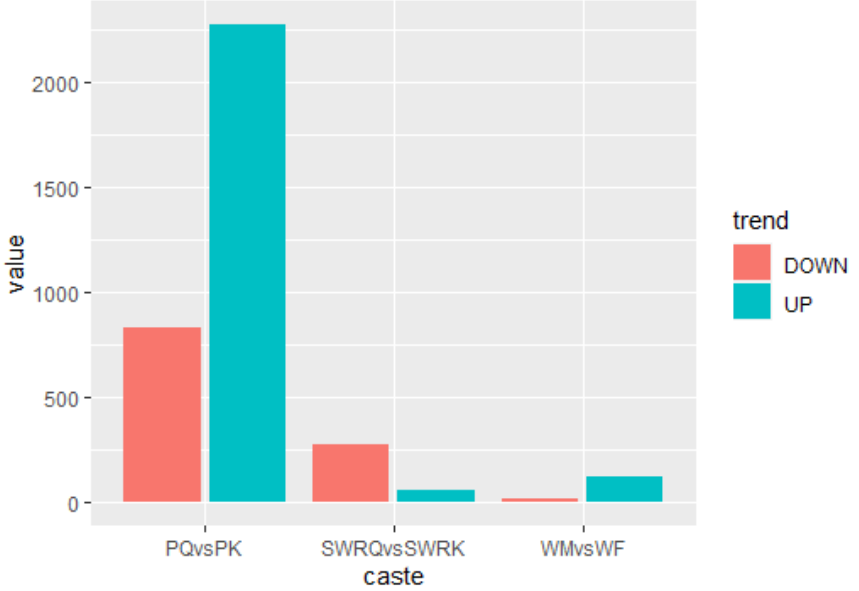
Figure 3. Differential expression of genes (DEGs) analysis across distinct castes of R. chinensis (SWRQ-vs-SWRK, PQ-vs-PK, and WM-vs-WF). The red column represents DEGs that are down-regulated, whereas the green column indicates DEGs that are up-regulated. To determine the significance of gene expression changes, FDR ≤ 0.001 and log2Ratio ≥ 1 were employed as thresholds.